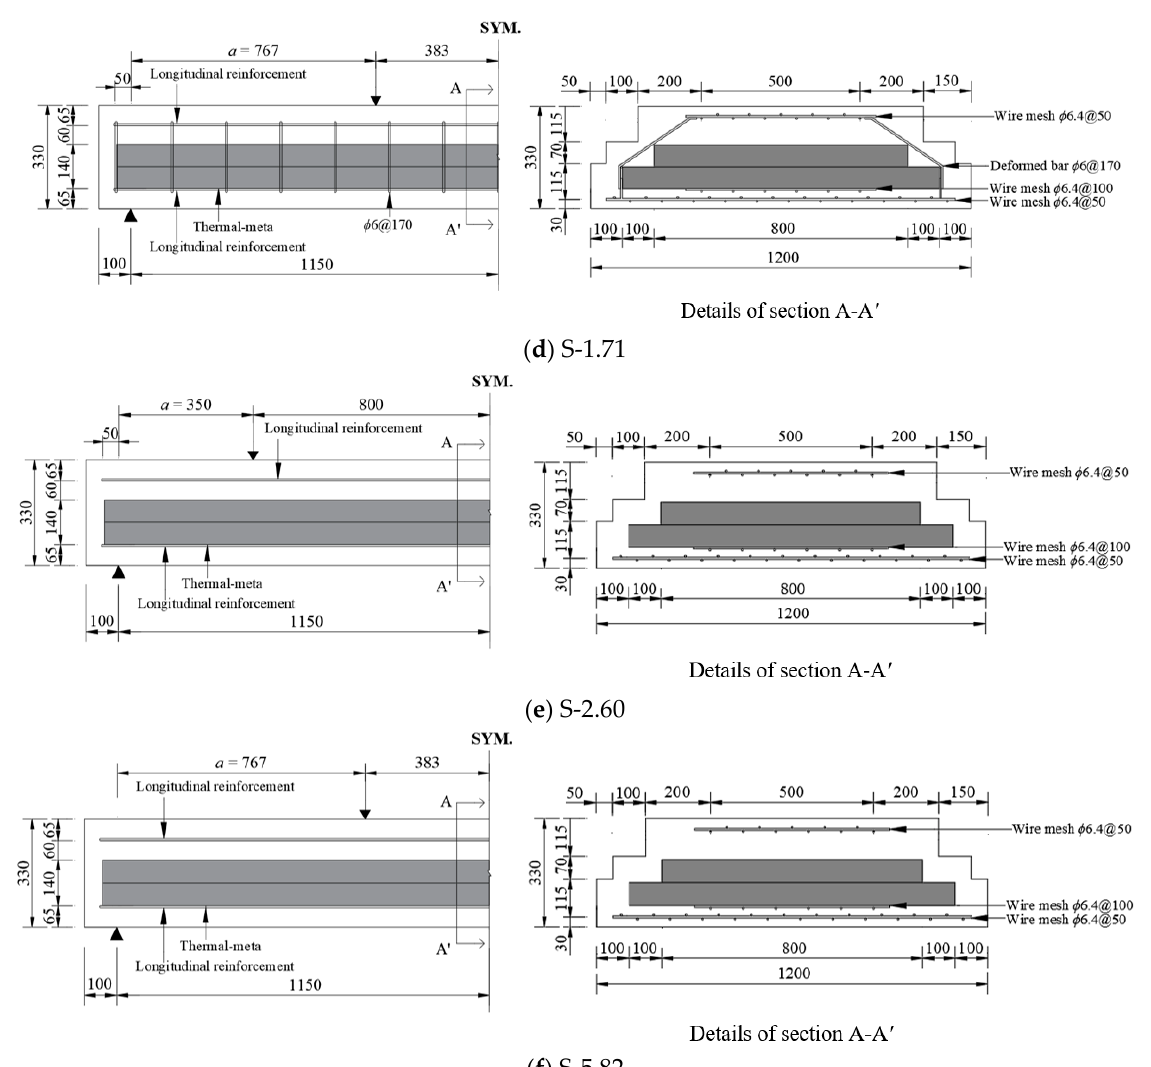
Figure 3. Details of the insulation-panel specimens (units: mm).